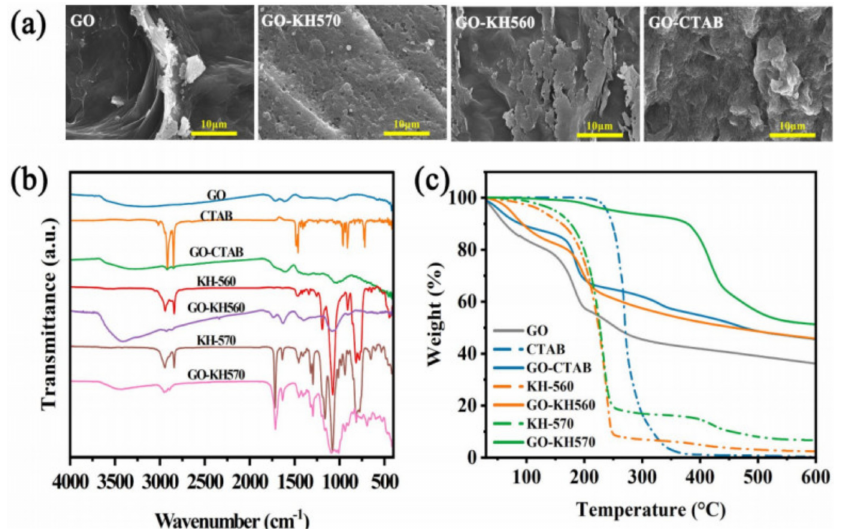
Figure 2. ( a ) SEM images of GO-modifiers, ( b ) FTIR, and ( c ) TGA curves of GO, surfactants, and corresponding